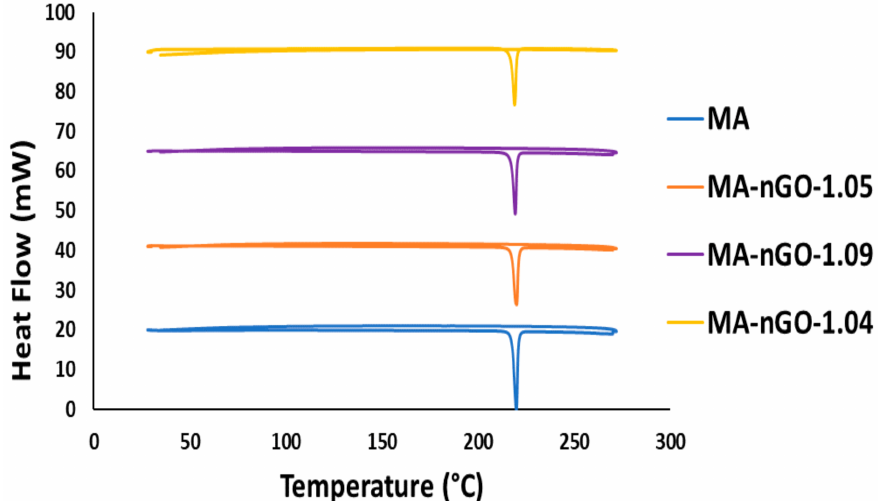
Figure 9. Differential Scanning Calorimetry analysis for MA drug composites.